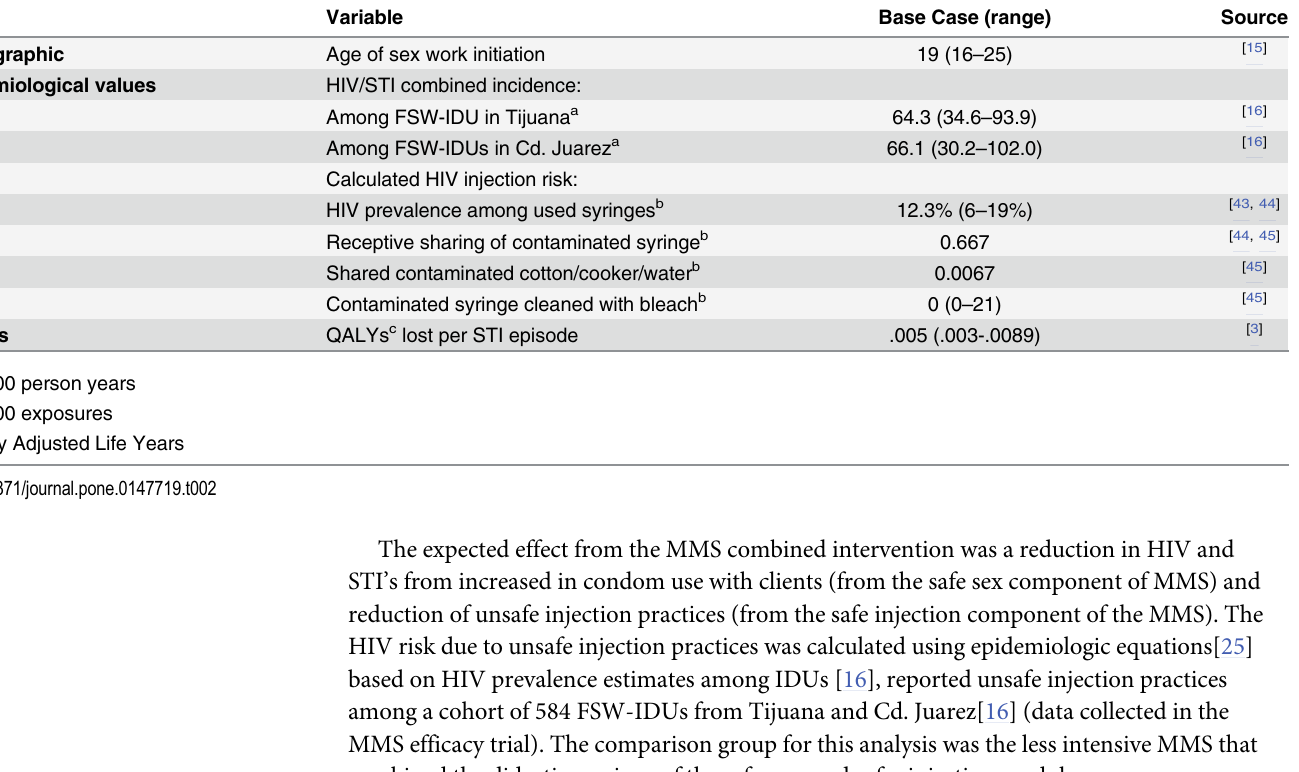
Table 2. Model base case clinical values and ranges used for sensitivity